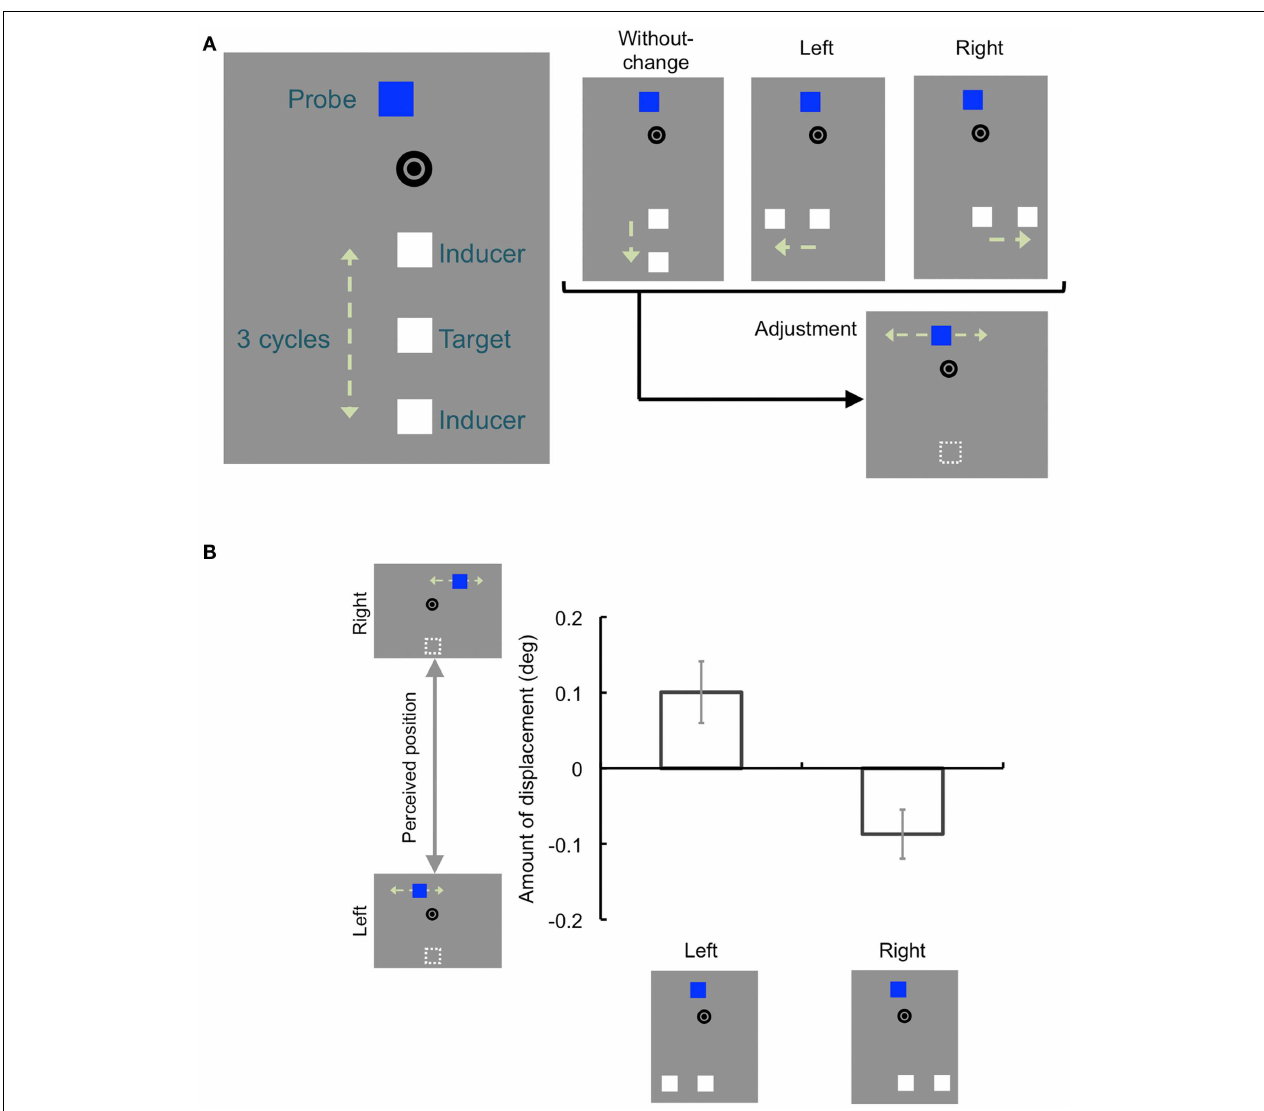
condition, the position shifted toward the left or right in the Left and Right conditions, respectively.Then, participants were asked to indicate the final perceived position of the target by adjusting the probe position. (B) Results. The adjustments in the Left and Right conditions were normalized against those in theWithout-change condition.The adjustments shifted in a direction opposite to that of AM. Error bars denote standard errors of the mean ( N =